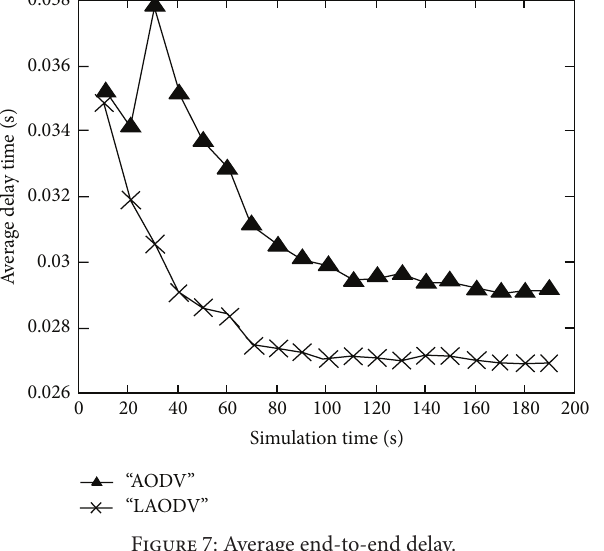
Figure 7: Average end-to-end delay. Figure 8: Packet loss probability.